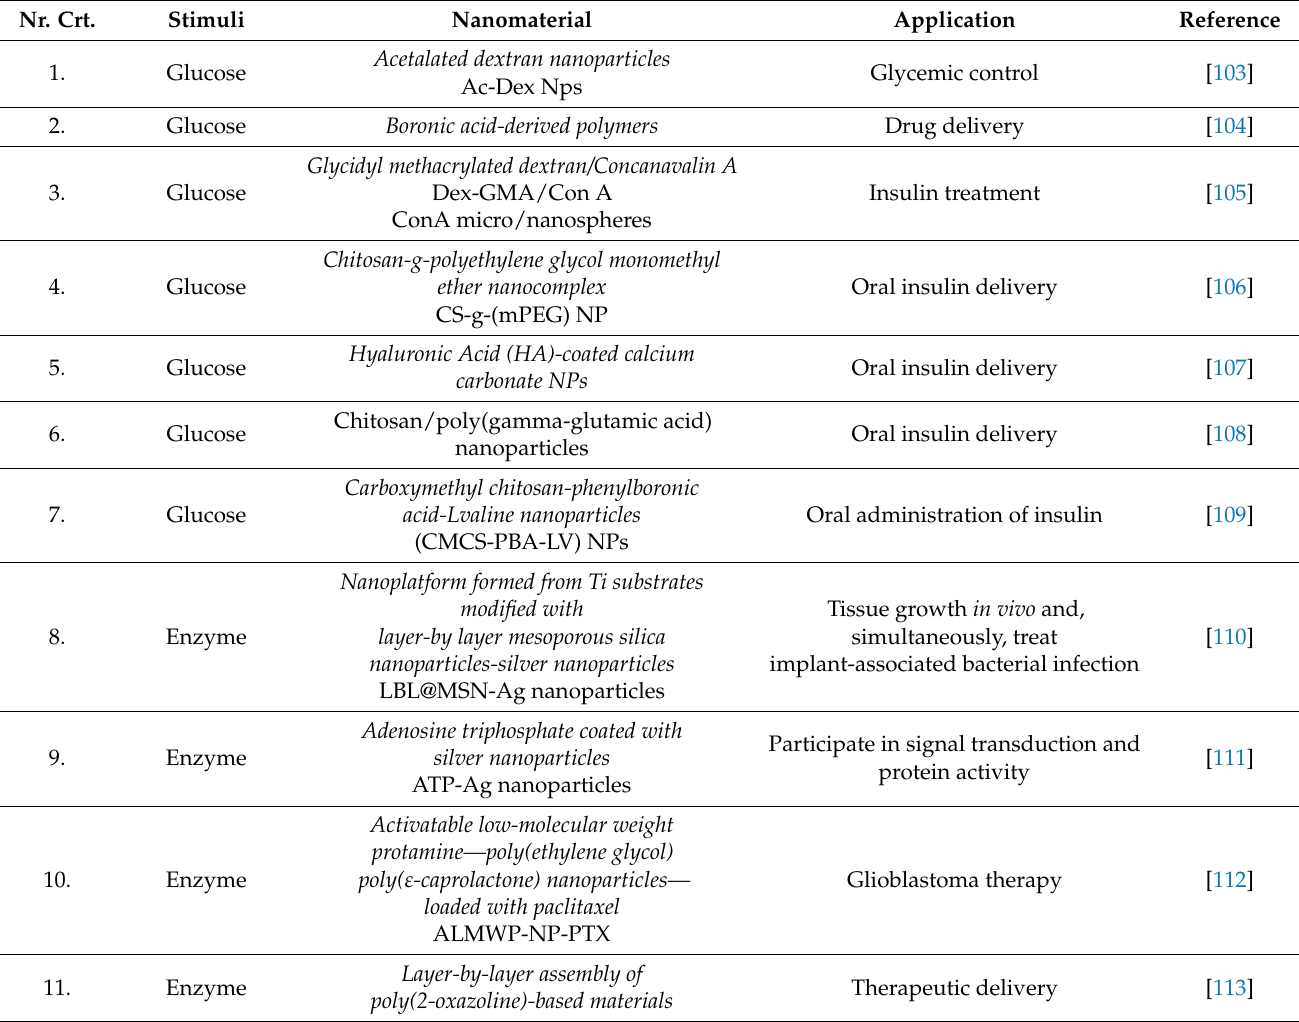
Table 3. Examples of biological-responsive nanomaterials and their biomedical applications. Nr.